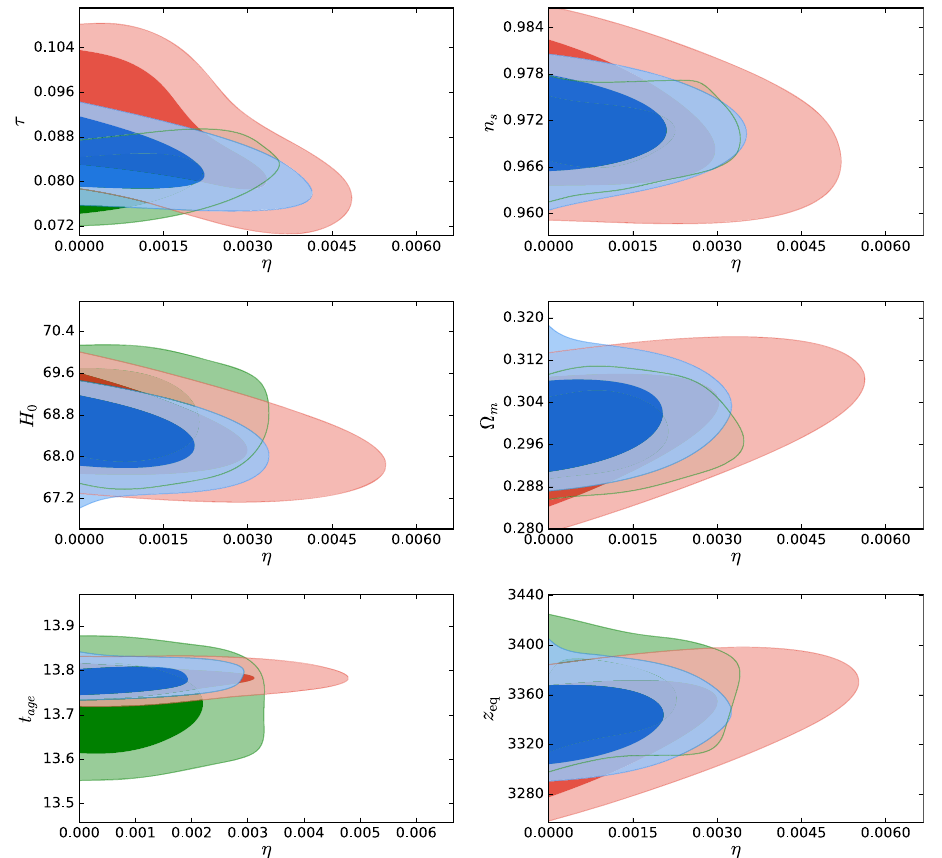
Fig. 8 The 2-dimensional marginalized contours of the V (cid:4) DE (blue), V ω DE (red) and VKDE (green) models in the η – τ , η – n η – H η – (cid:11) η – t s , 0 , m , age and η – z eq planes by using the data combination CSBCHLW,